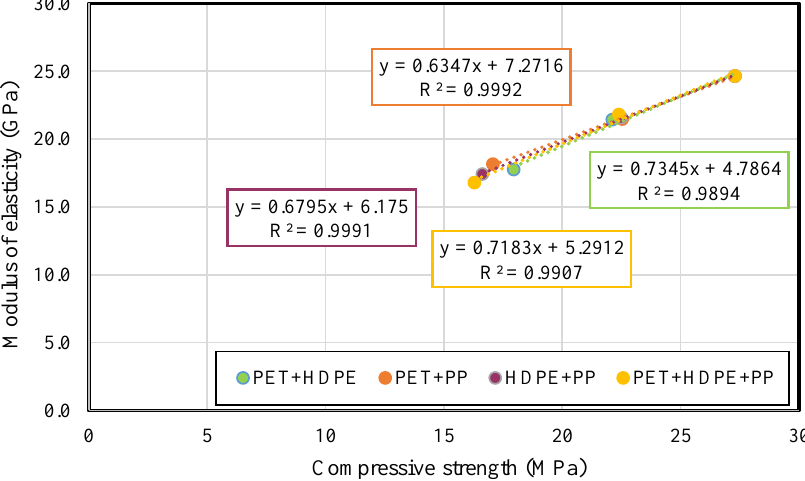
Figure 13. The relationship between the compressive and the predicted modulus of elasticity.